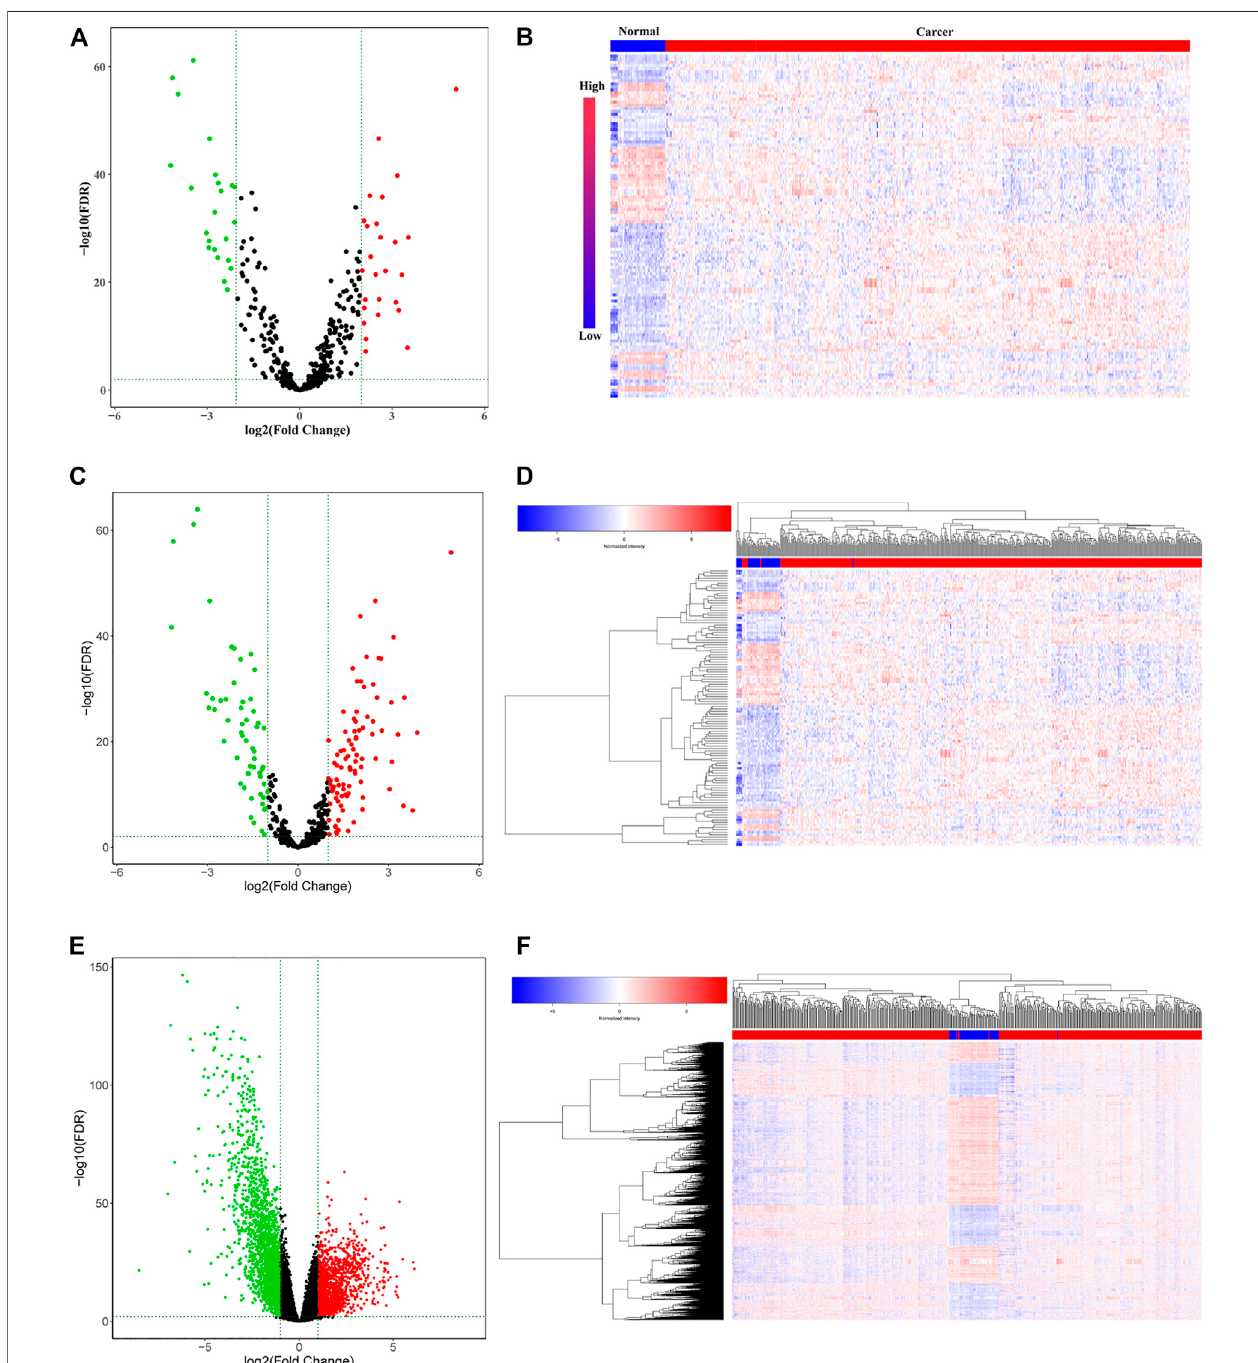
FIGURE 1 | Differentially expressed RNAs (lncRNAs, miRNAs, and mRNAs) in the RNA expression pro fi le of lung adenocarcinoma in TCGA. (A) Volcano plot and (B) heatmapforthedifferentiallyexpressed lncRNAs. (C) Volcanoplotand (D) heatmapforthedifferentiallyexpressed miRNAs. (E) Volcanoplotand (F) heatmapforthe differentiallyexpressedmiRNAs.Thereddotsrepresentupregulatedgenes,andthegreendotsrepresentdownregulatedgenes.Theblackdotsrepresentgeneswithno signi fi cant difference.